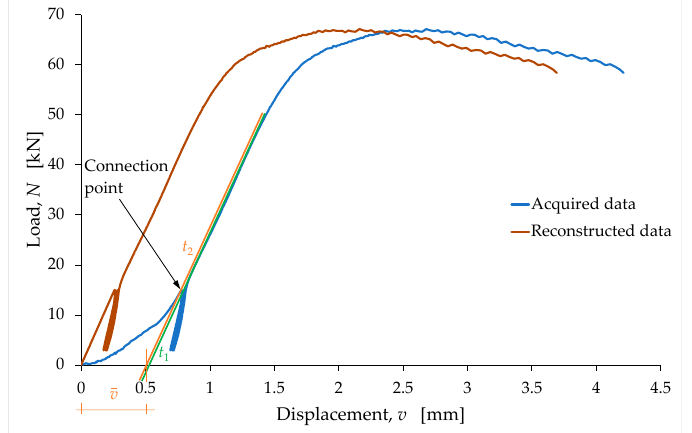
Figure 8. Identification of the slope for the replacement of the first branch of the N / v curve with a straight-line segment, and of the translation, v , of the reconstructed and nonreconstructed branches: LT6 specimen.